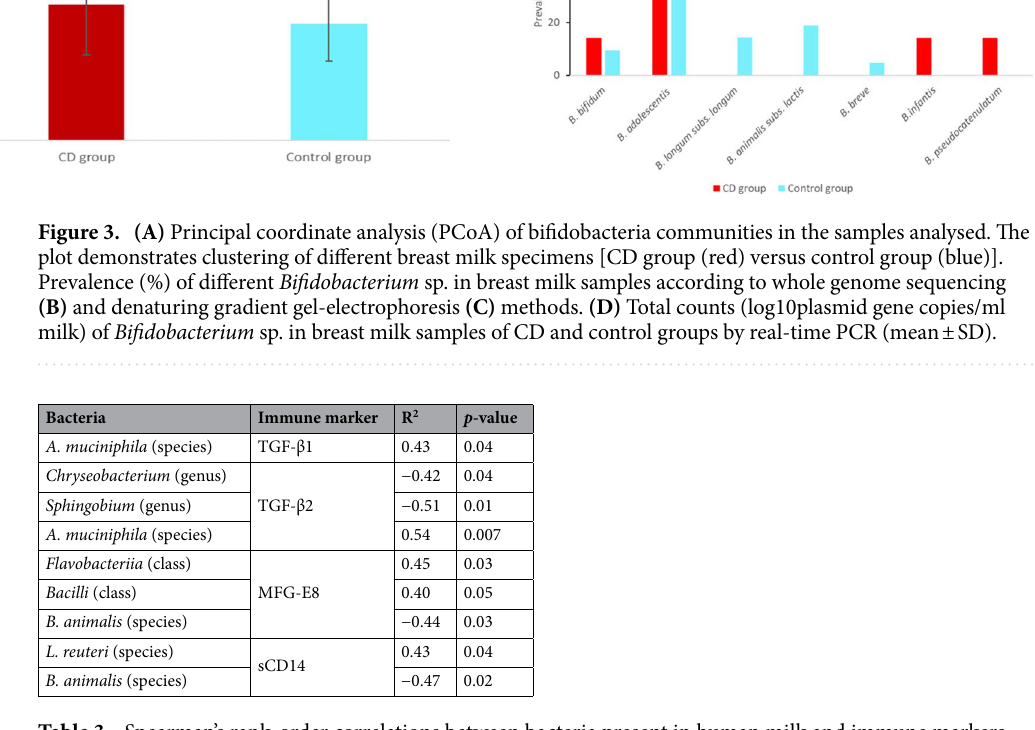
Table 3. Spearman’s rank-order correlations between bacteria present in human milk and immune markers .